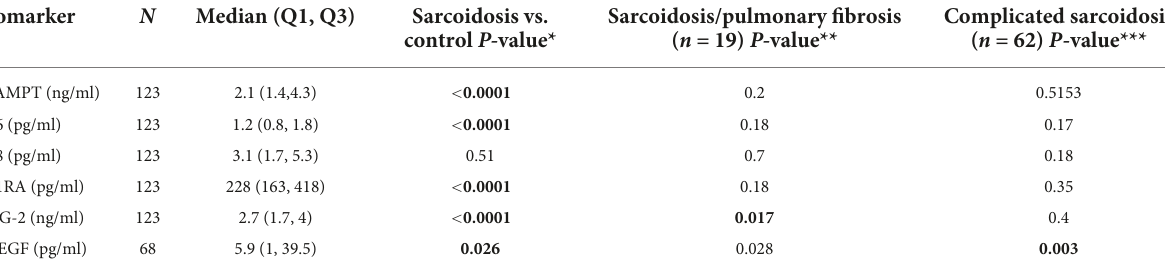
TABLE 3 Biomarker plasma levels in sarcoidosis.